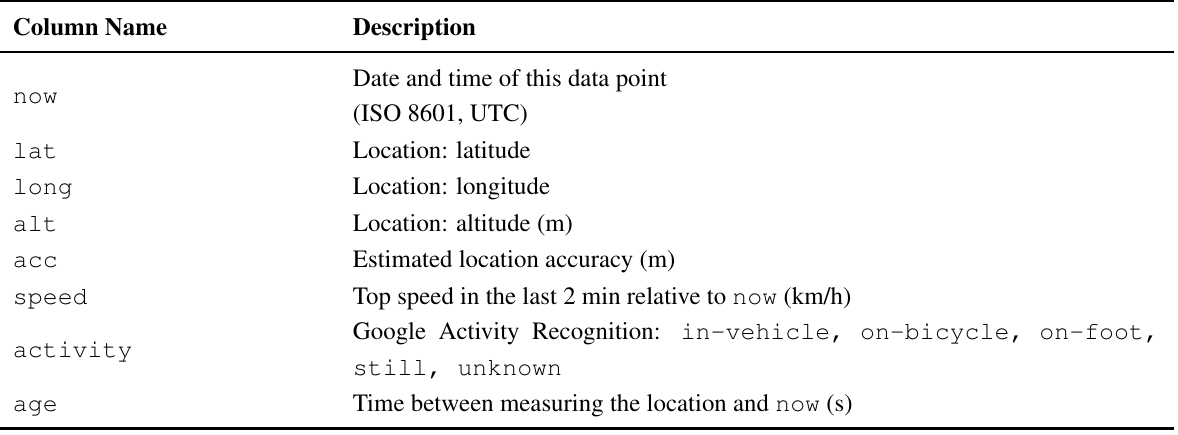
Table 1. Mobility data collected by BX Tracker.